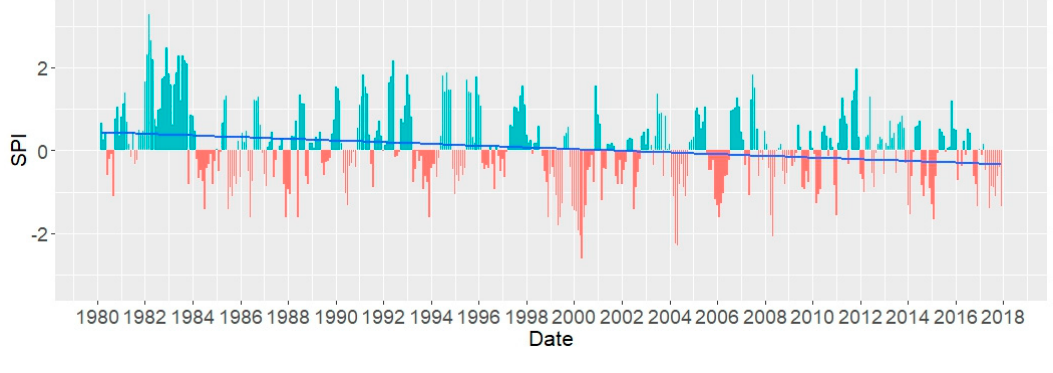
Figure 4. Three-month SPI of the Barkhan station.